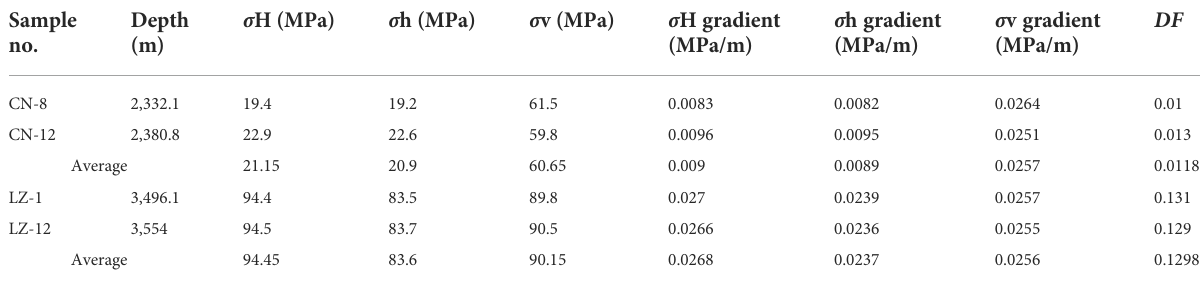
TABLE 3 Test results of in-situ stress of the longmaxi formation in the study area. Sample no.